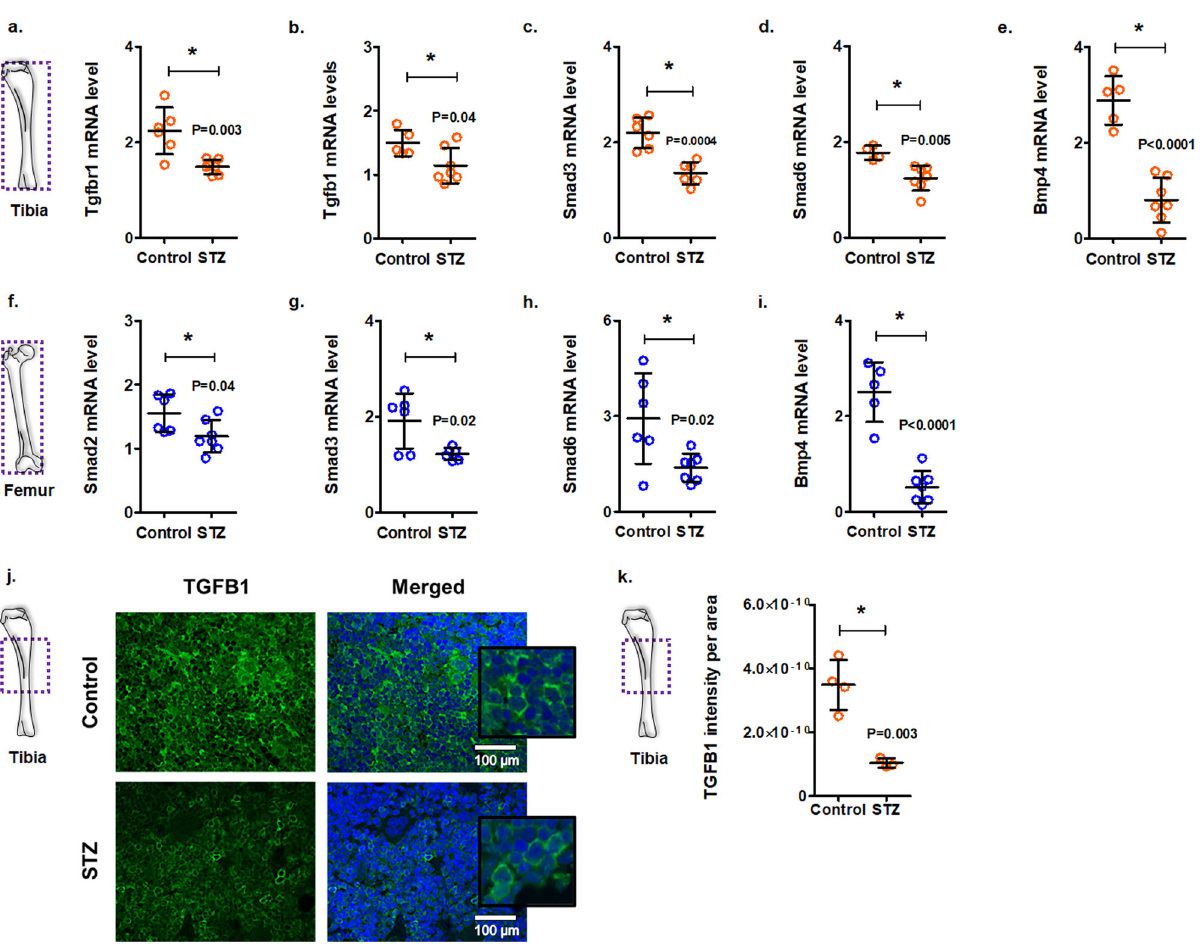
Fig. 3 Suppressed TGFB pathway in the bone marrow of streptozotocin-induced diabetic mice at 1 month. Tibia and femur samples were harvested from control and streptozotocin (STZ)-induced diabetic mice after 1 month. a – e mRNA levels of the TGFB pathway genes in the tibiae of mice [For panels a , b , data normalized to Actb, Atp5f1 , and Pgk1 ; for panels c – e , data normalized to Actb and Gapdh ; Mean ± SD; n = 6 control and 7 STZ in panel a , 5 control and 7 STZ in panel b , 6 control and 6 STZ in panel c , 4 control and 7 STZ in panel d , 5 control and 7 STZ in panel e ; each data point represents a mouse; two-tailed student ’ s t -test: * p < 0.05]. f – i mRNA levels of the TGFB pathway genes in the femurs of mice [For panels f – i , data normalized to Actb and Gapdh ; Mean ± SD; n = 6 control and 7 STZ in panel f , 6 control and 6 STZ in panel g , 6 control and 7 STZ in panel h ; 5 control and 7 STZ in panel i ; each data point represents a mouse; two-tailed student ’ s t -test: * p < 0.05]. j Immunostaining of tibia marrow for TGFB1 (green). Sections were counterstained with DAPI (blue) [scale bar = 100 μ m]. Inserts showing higher magni fi cation. k Quanti fi cation of TGFB1 intensity per area, as determined by ImageJ [Mean± SD; n = 4 control and 3 STZ; two-tailed student ’ s t -test: * p <